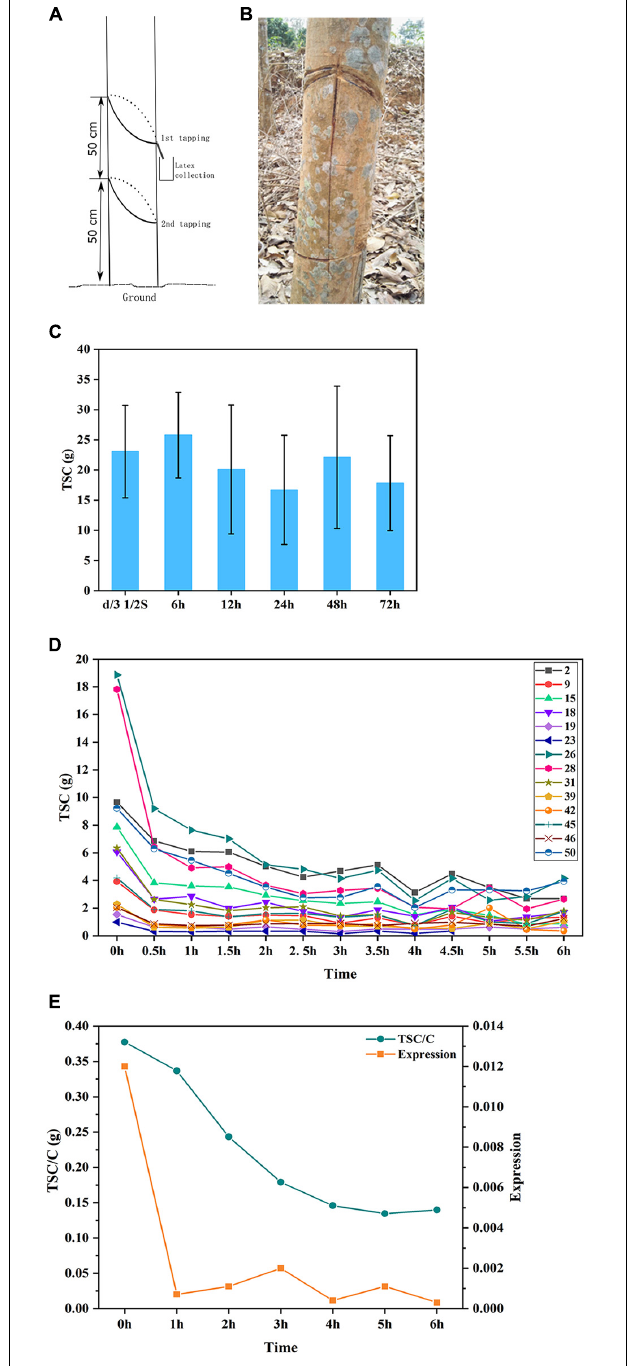
FIGURE 6 | Latex regeneration study identified HbsnoR28 as involved in latex regeneration regulation. (A,B) Demonstration of insulated tapping system (ITS). (C) Latex yield comparison between conventional S/2 d/3 tapping system and ITS with intervals of 6 to 72 h. No significant yield reduction was found for ITS 6 h. (D) Yield (TSC) drop trends of continuous tapping with 30-min intervals. A relatively stable TSC level was achieved after 3 h. The number denotes 14 of 50 F1 individual trees, respectively. (E) Profiles of HbsnoR28 expression and TSC/C under continuous tapping with the ITS. At least three biological replicates were used for these studies.